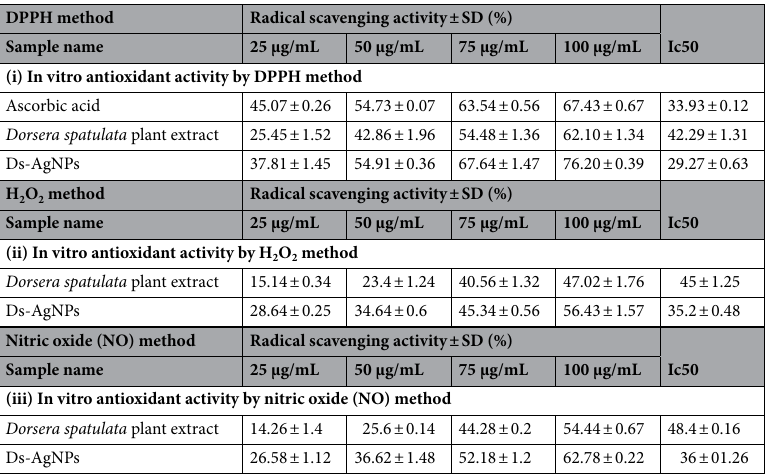
Table 1. In vitro antioxidant activity of Ds-PE and Ds-AgNPs by DPPH method, H 2 O 2 method and Nitric oxide (NO)